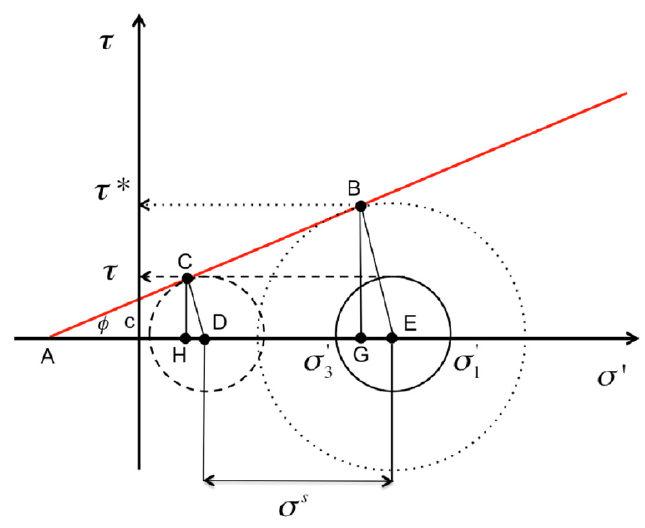
Figure 1. Illustration of the concept of local factor of safety [49].